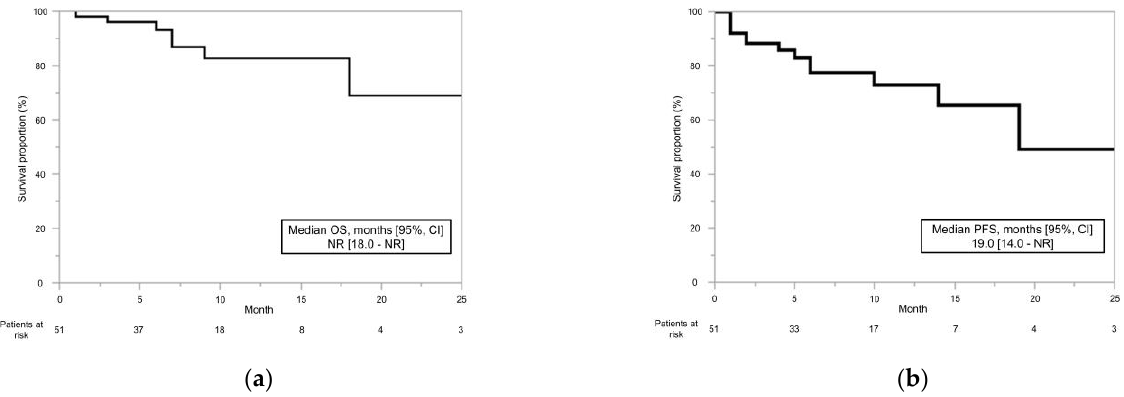
Figure 1. Overall survival (OS) and progression-free survival (PFS) in patients with advanced or metastatic renal cell carcinoma who received immune checkpoint inhibitors and tyrosine kinase inhibitors were estimated using the Kaplan–Meier method. ( a ) OS at 6, 12, and 18 months was 93.1%, 82.5%, and 68.8%, respectively, and did not reach the median OS. ( b ) PFS at 6, 12, and 18 months was 77.4%, 72.8%, and 65.5%, respectively, and the median PFS was 19.0 months. With respect to age, the median PFS for patients aged ≥ 70 years was significantly shorter than that for patients aged <70 years (19.0 months vs. NR, p = 0.018) (Figure 2a); with respect to IMDC risk stratification, the median PFS was significantly shorter for patients at poor risk than for those at good/intermediate risk (6.0 months vs. NR, p = 0.038) (Figure 2b). There was no significant association between PFS and sex ( p = 0.24), number of